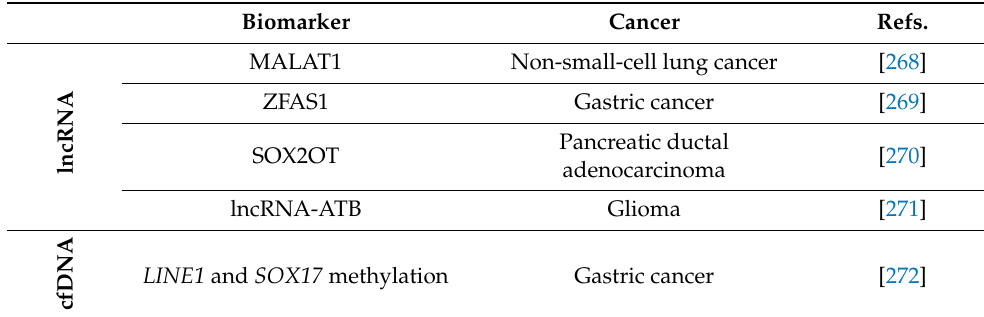
Table 3. Exosomal long non-coding RNAs (lncRNAs) and exosomal cell-free DNA (cfDNA) involved in the development of some common